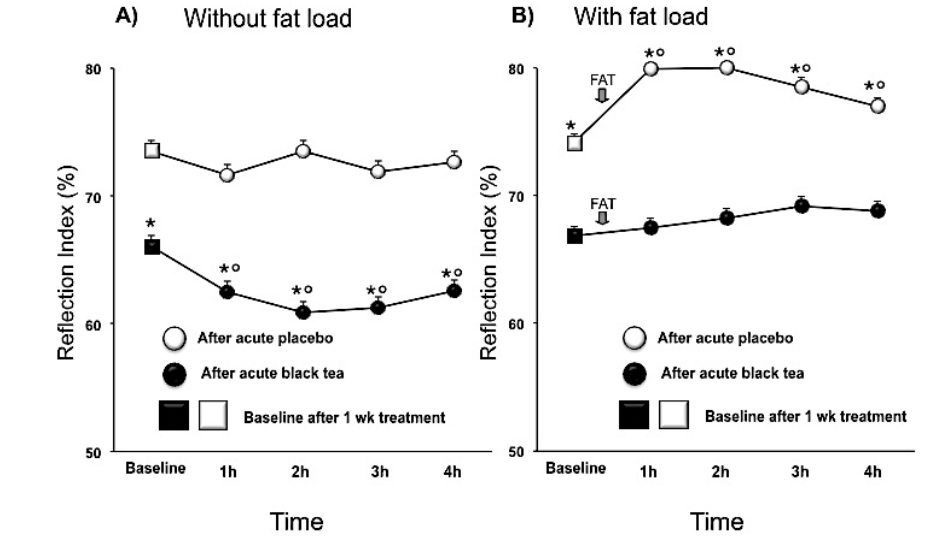
Figure 2. Effect of 1 week placebo (white) and black tea (black) administration on baseline (square) values (Panel A and B ) of reflection index and acute effects without and with fat load (Panel A and B ). Data are presented as LSmeans ± SE. In all panels vertical lines indicate SE and asterisks (*) indicate significant differences with respect the placebo phase (Panel A and B ) while circles (°) indicate significant differences from baseline values (Panel A and B ). Differences are considered significant when p < 0.05.